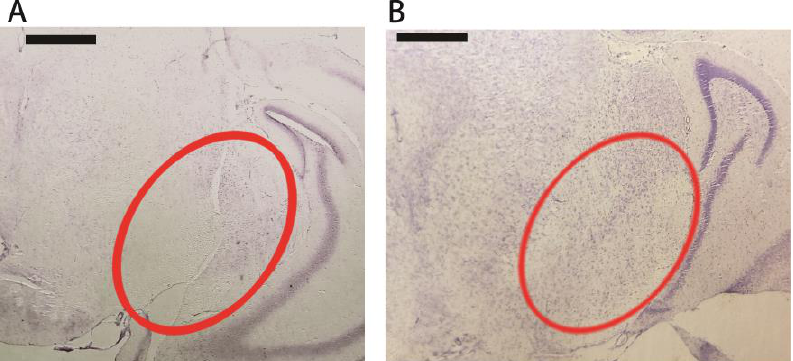
Figure 5. Effects of high CO 2 inhalation. Nissl staining of paraffinized coronal brain slices of mice exposed to rotenone. ( A ) untreated ( B ) CO 2- treated. Scale bar : 500 μm. SN is circled in red.